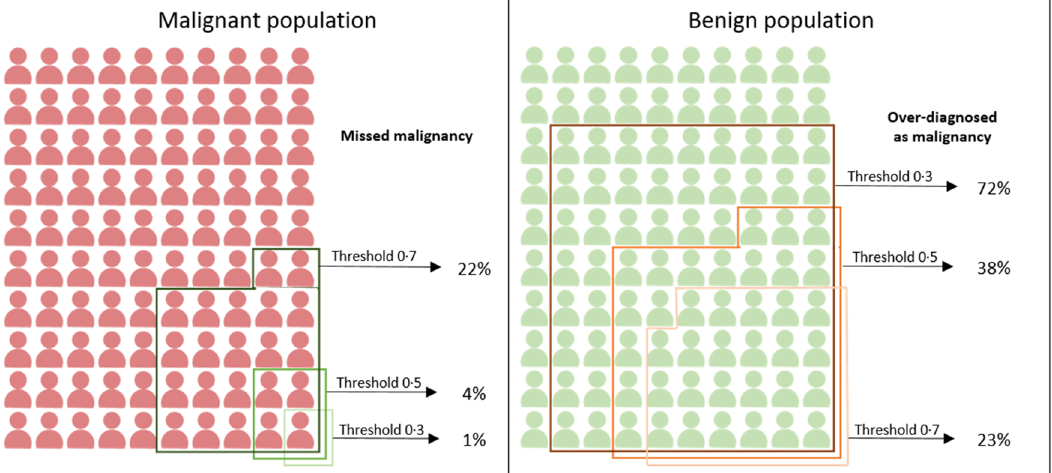
Figure 5. Performance of the algorithm according to the probability threshold changes. In malignant population (100 unit participant), there were missed malignancy prediction in 22%, 4% and 1% for threshold 0.7, 0.5 and 0.3, respectively. In benign population (100 unit participant), there were over-diagnosis as malignancy in 72%, 38% and 23% for threshold 0.7, 0.5 and 0.3, respectively.